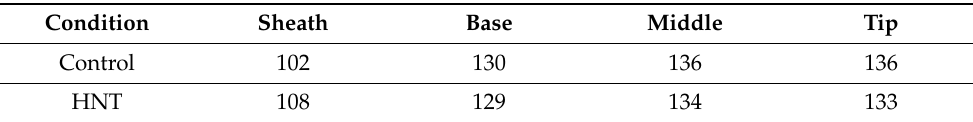
Table 1. Number of metabolites after filtering of metabolites with missing values for correlation analysis per segment and